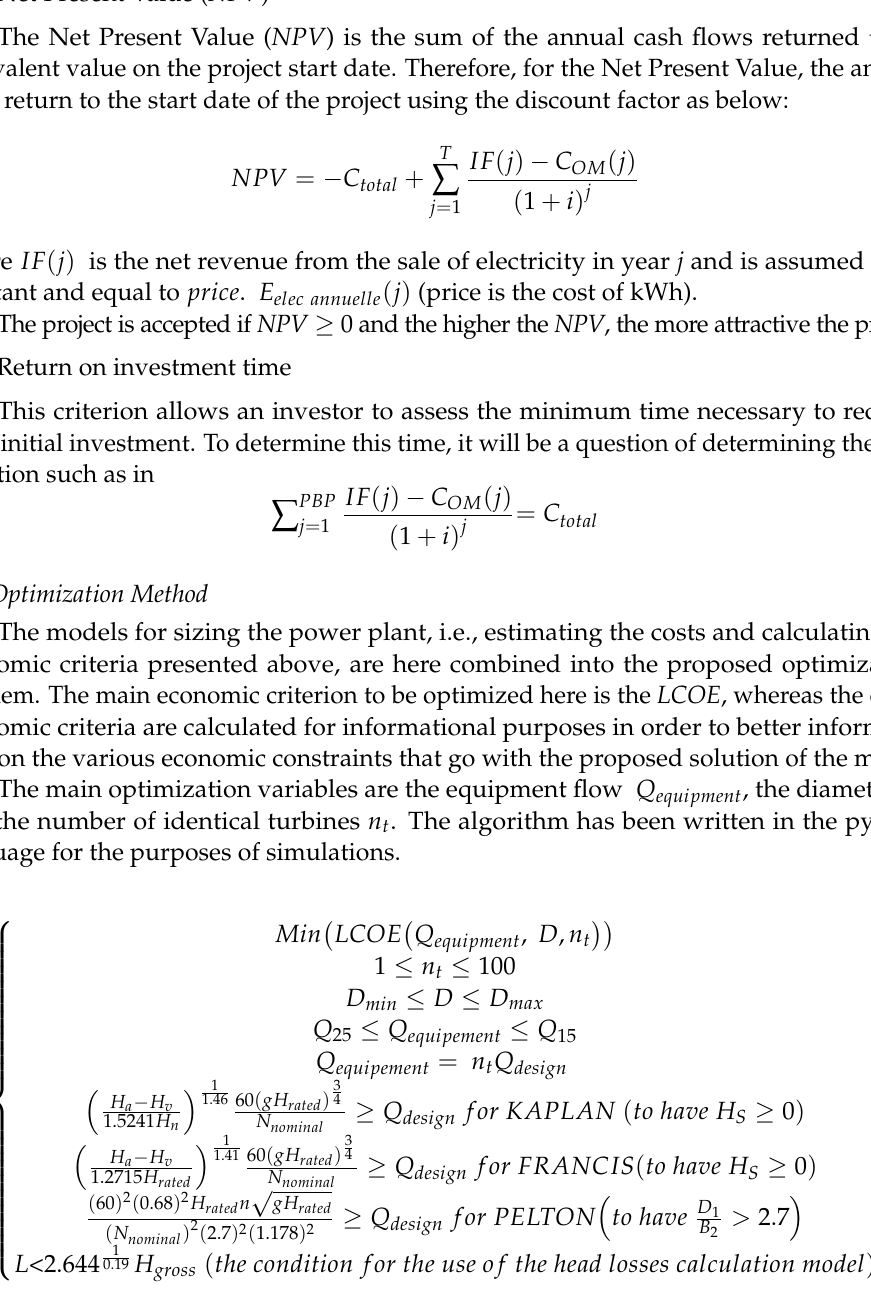
Figure 6 below summarizes the methodology